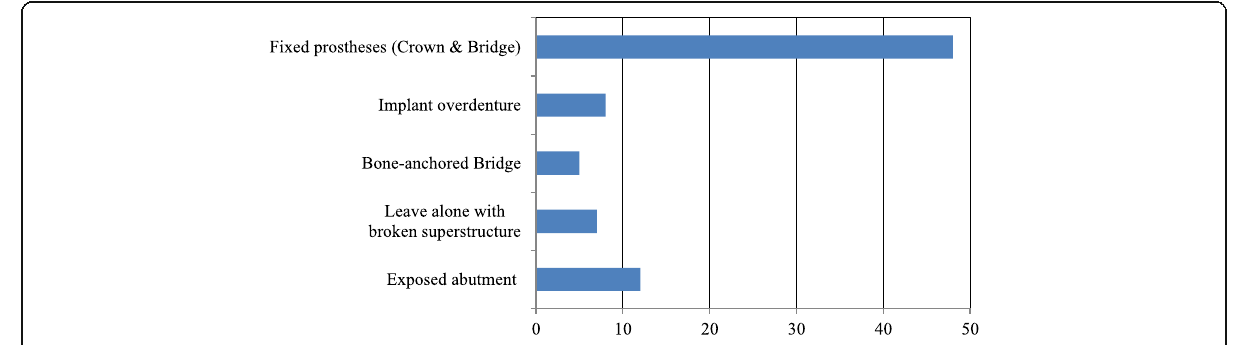
Fig. 1 Q5. Types or status of implant prostheses encountered in domiciliary dental care (multiple answers were